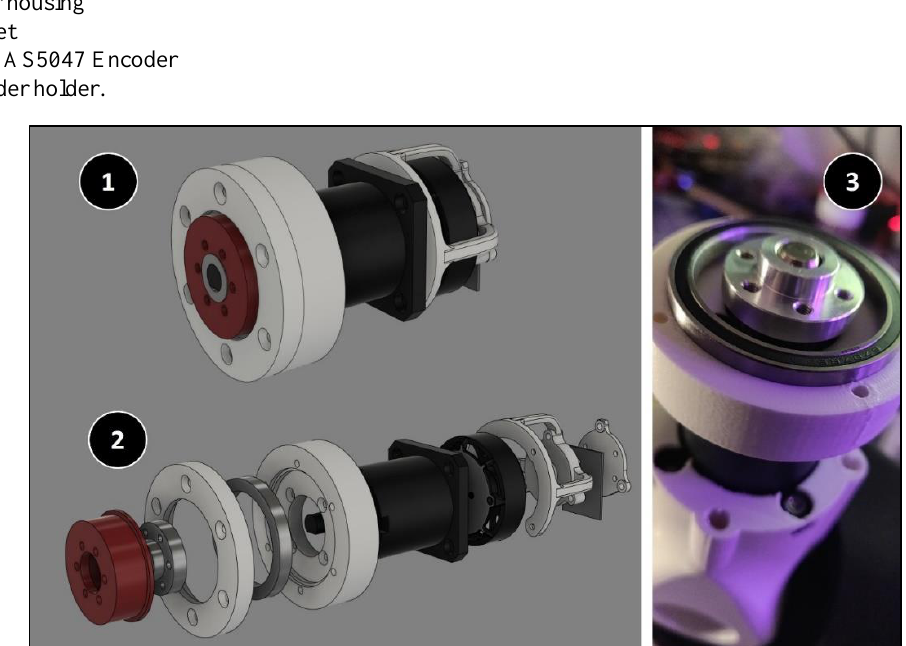
Figure 2. Design of the actuator (1) and of the exploding parts (2) and prototype (3). On panel (2) from the left to the right, the Output shaft, Aluminium Mounting hub, Output housing front, 61707-2RS Dunlop Sealed Thin Section Ball Bearing, Output housing